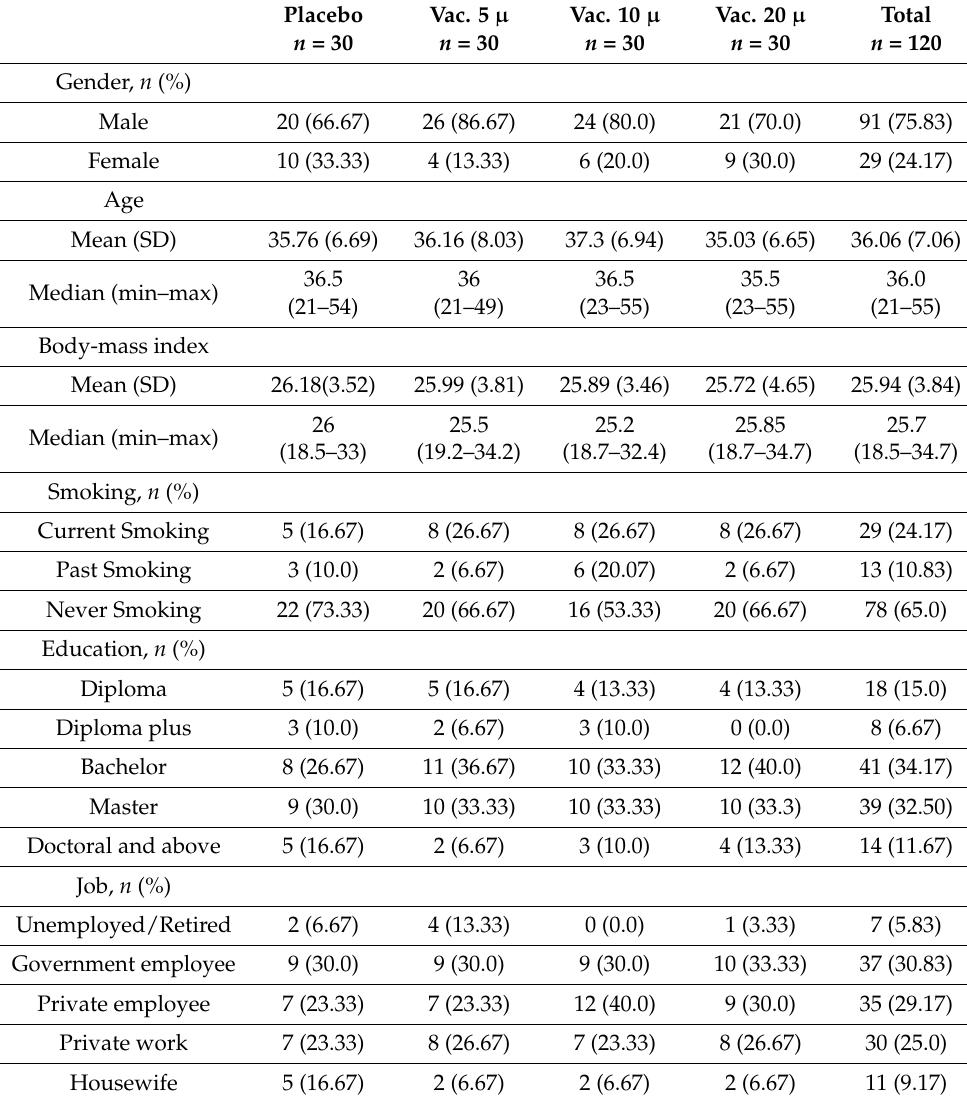
Table 2. Baseline comparison of the 120 randomized